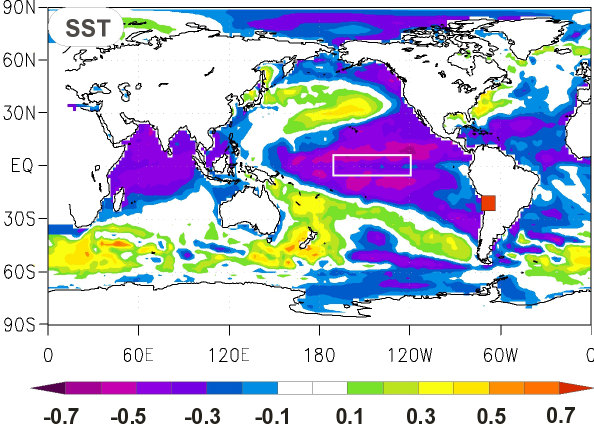
Fig. 5. Spatial correlation field between the annual (November– October) precipitation reconstruction and 2 . 5 × 2 . 5 ◦ gridded monthly averaged November–October sea surface temperature (SST) for the interval 1948–2006 (NCEP-NCAR reanalysis). The white box indicates the Ni˜no 3.4 region in the tropical Pacific. The reconstructed precipitation region is indicated by the red